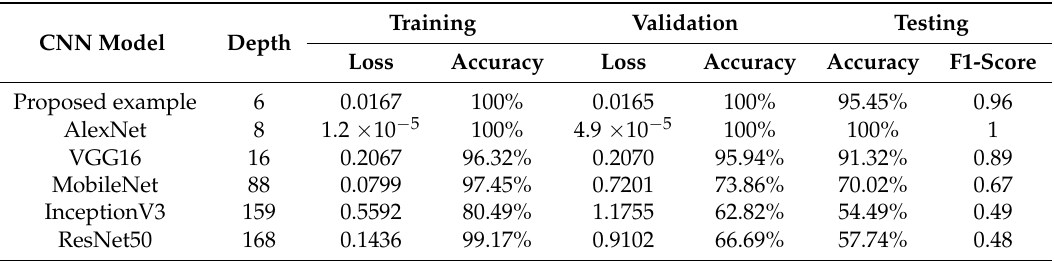
Table 5. Comparison between the proposed example and pre-trained models for fruit classification on Fruit-360 dataset